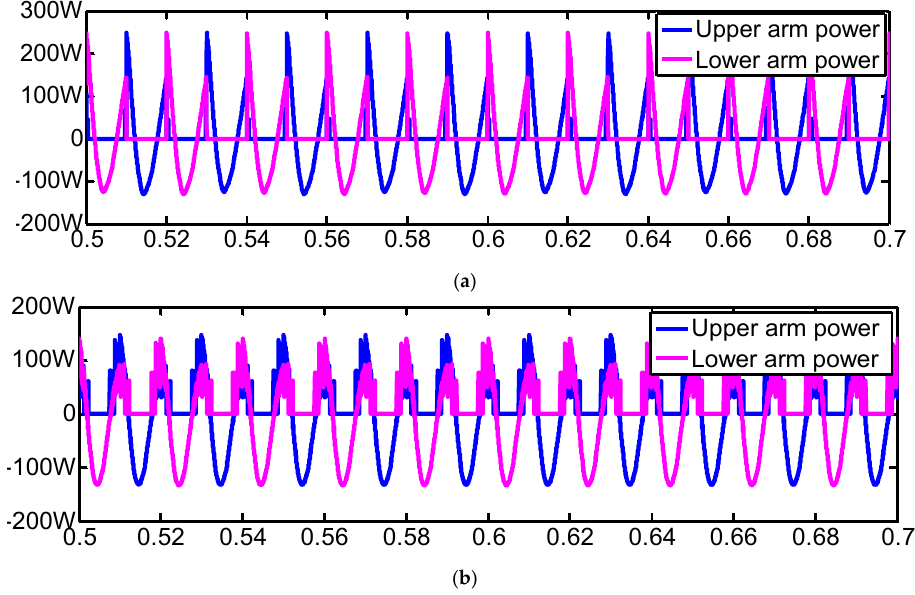
Figure 22. Arm powers of the proposed hybrid MMC under different λ : ( a ) λ = 1; ( b ) λ = 0.5.